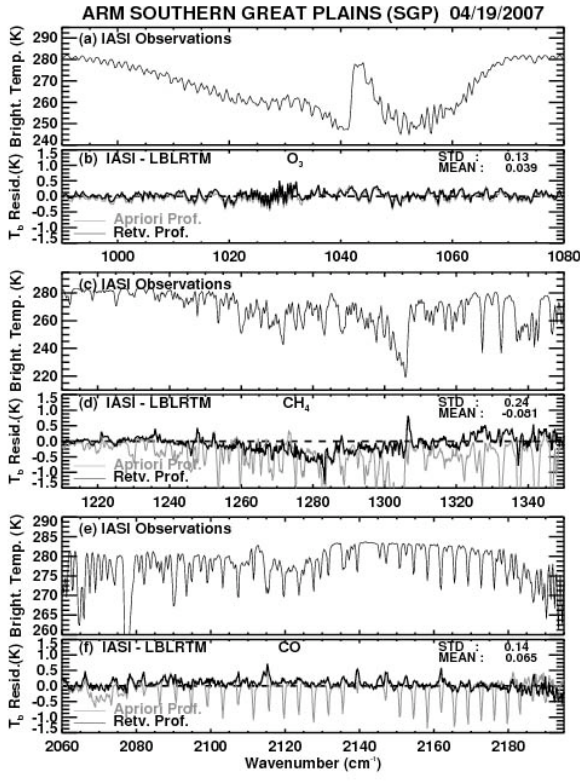
Fig. 21. IASI observations and residuals for the ARM SGP land case for the ozone region (a, b) , the methane region (c, d) and the carbon monoxide region (e, f)